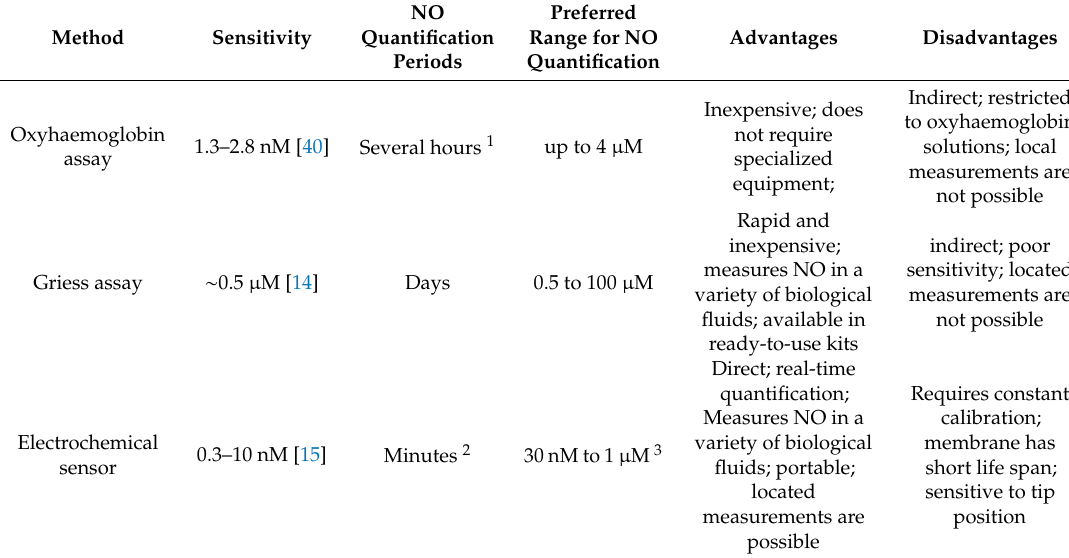
Table 1. Summary of the main features of the three NO quantification methods